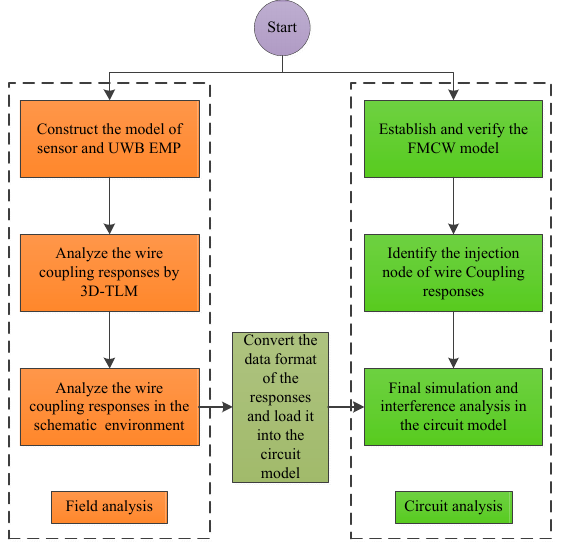
Figure 2. The flowchart of the proposed hybrid